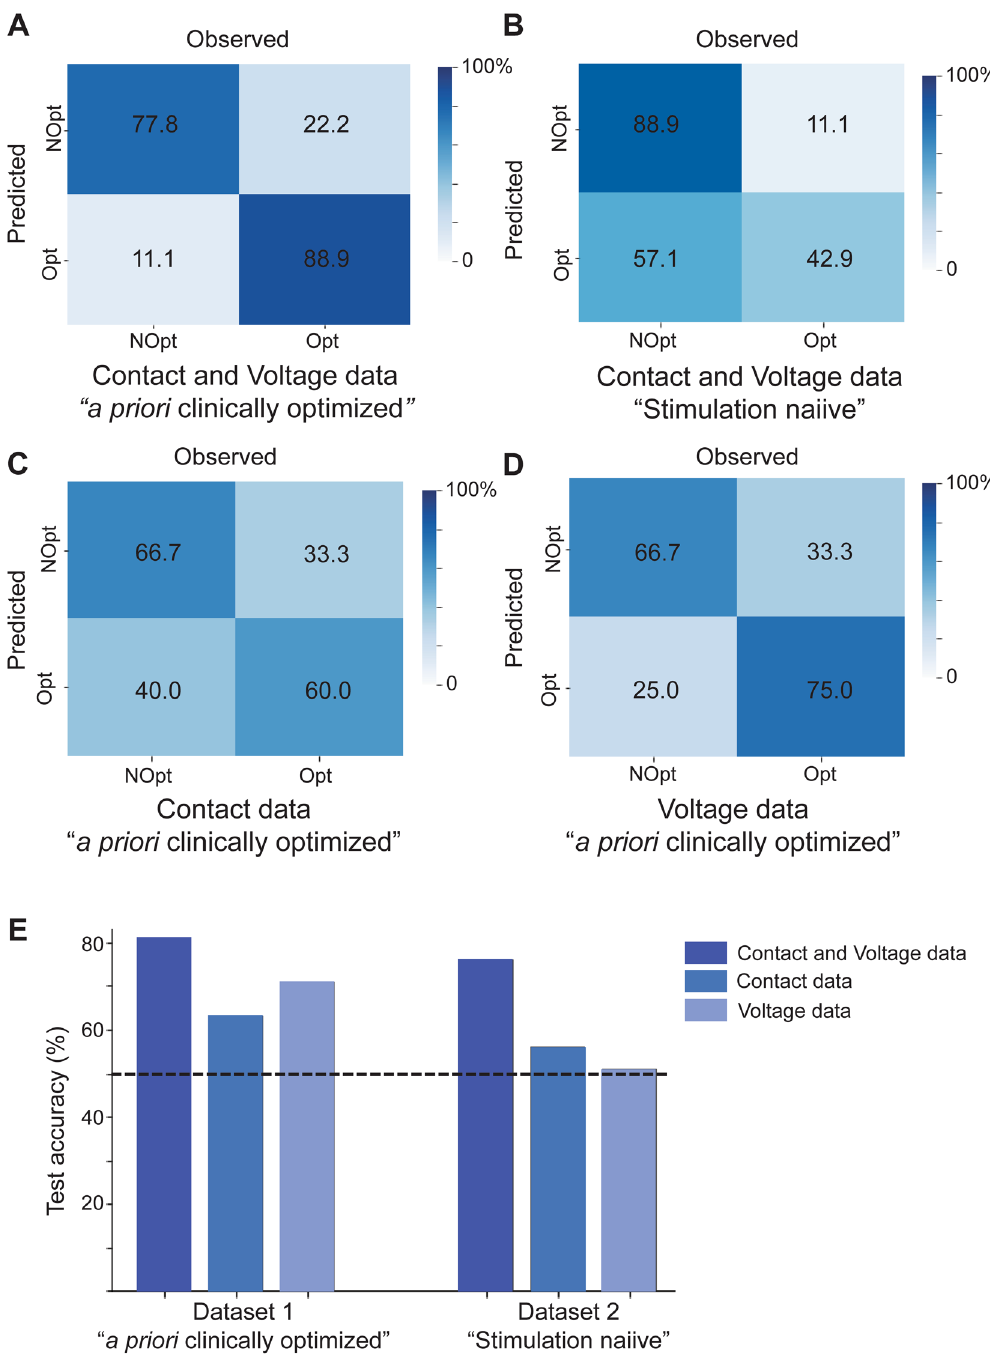
Fig. 5 fMRI responses predict optimal DBS parameters. Confusion matrices depicting the performance of classi fi ers trained to identify optimal DBS settings using features from A contact and voltage cohorts, C contact cohort alone, and D voltage cohort alone in an independent test set ( n = 9 a priori clinically optimized patients). B Confusion matrix depicting the performance of the classi fi er trained to identify optimal DBS settings using features from contact and voltage cohorts in an independent test set ( n = 9 stimulation naïve patients). E Summary of performance (overall accuracy) for classi fi ers in A – D . Bars from dataset 1 depict classi fi er test accuracy on n = 9 a priori clinically optimized patients. Bars from dataset 2 depict classi fi er test accuracy on n = 9 stimulation naïve patients. Dashed line indicates chance at 50% accuracy. Source data are provided as a Source Data fi le. DBS deep brain stimulation, fMRI functional magnetic resonance imaging, NOpt non-optimal, Opt BOLD response maps associated with non-optimal stimulation tracts 33 ; (2) STN has associative and limbic territories beyond its showed engagement of non-motor circuits, including the visual dorsolateral motor regions 34 . As the stimulated area moves fur- ther from dorsolateral STN, off-target STN areas and tracts are cortices and operculum. The mechanisms underlying these effects likely stimulated. This undesired recruitment of non-motor areas are not fully understood, but there are at least two possible could be considered “ friendly fi re ” and be responsible for some of explanations: (1) STN is surrounded by several white matter